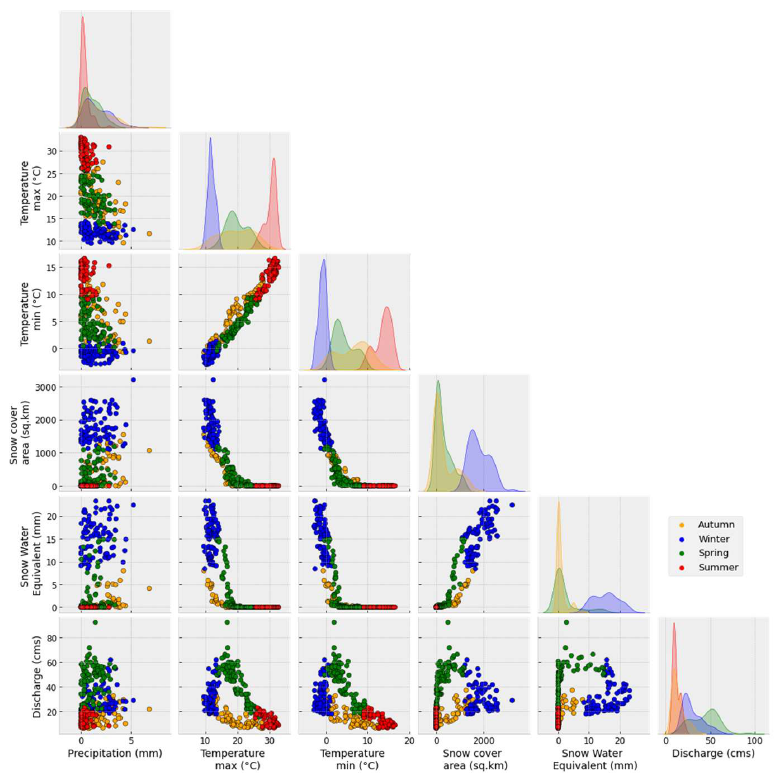
Figure 8. Correlation between SCA, SWE, discharge, precipitation, and maximum and minimum temperature.